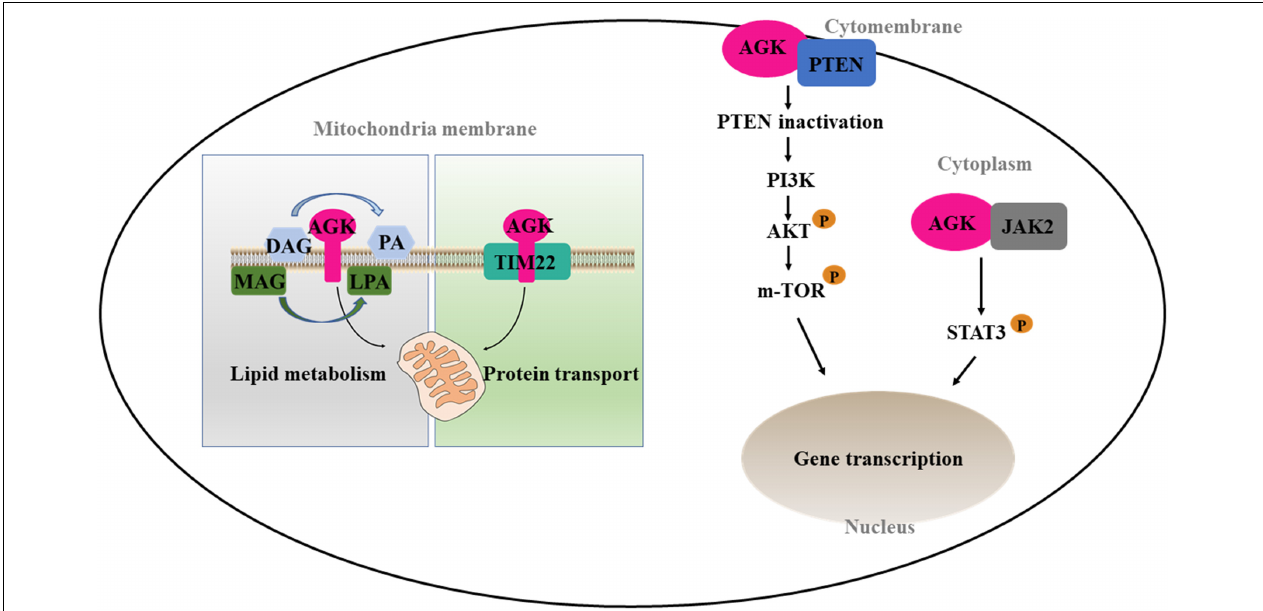
FIGURE 3 | Kinase and non-kinase function of AGK. AGK as a kinase can phosphorylate MAG and DAG to form PLA and PA, respectively. As a non-kinase, AGK participates in mitochondrial protein transfer as a part of the TIM22 complex. Also, extramitochondrial AGK has a hand in the glycolysis of CD8 T cells and the formation of platelets by interacting with PTEN or JAK2, respectively. MAG, monoacylglycerol; DAG, diacylglycerol; LPA, lysophosphatidic acid; PA, phosphatidic acid; TIM22, translocase of the inner membrane 22; PTEN, phosphatase and tension homolog; PI3K, phosphatidylinositol 3-kinase; Akt, protein kinase B; mTOR, mammalian target of rapamycin; JAK2, Janus kinase 2; STAT3, signal transducer and activator of transcription